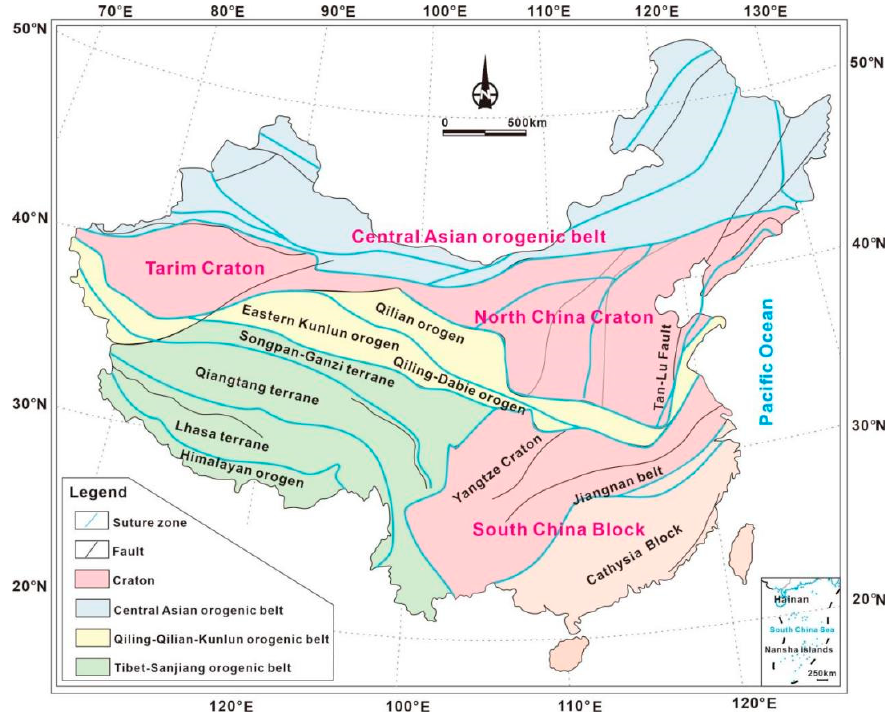
Figure 2. Generalized geological map and tectonic sub-division of China (modified after Qiu et al. [26]). Table 1. The distribution statistics of Chinese gemstones in each province.